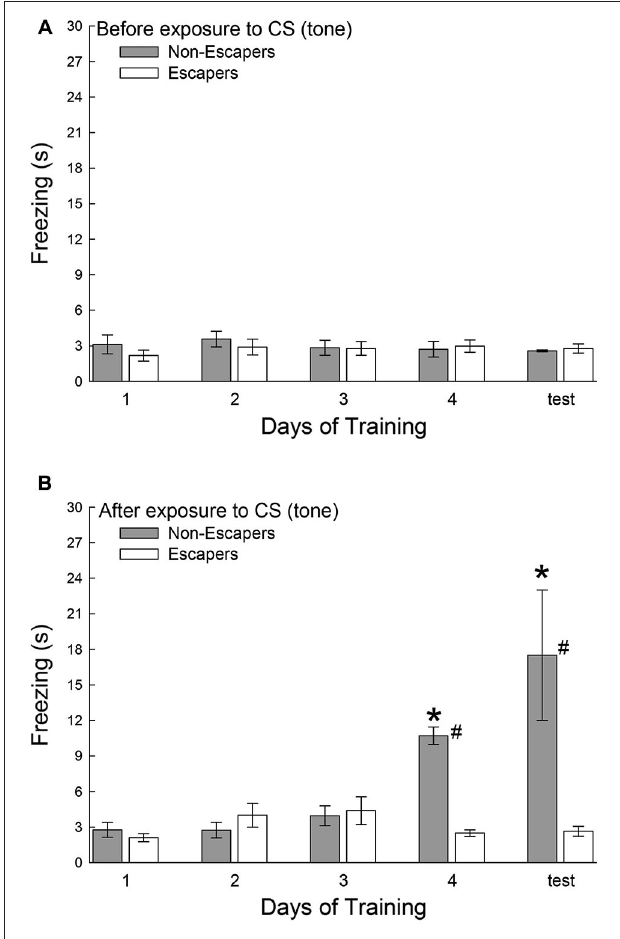
FIGURE 3 | Effects of decision-making on classical fear conditioning . Mean ( ± SEM) duration of freezing (A) before and (B) after the conditioned stimulus (CS = tone), but prior to exposure to the aggressive CD1 and subsequent social interaction. Increased freezing was significant (* indicates statistical significance compared with days 1–3, p < 0.05; N = 5 − 9) only in mice that chose to remain submissively (Non-Escapers, gray bars) after training day 3. Escaping mice (white bars) do not exhibit Pavlovian conditioning to the auditory cue (CS = tone; # indicates significant differences between Non-Escapers and Escapers on that day, p < 0.05).